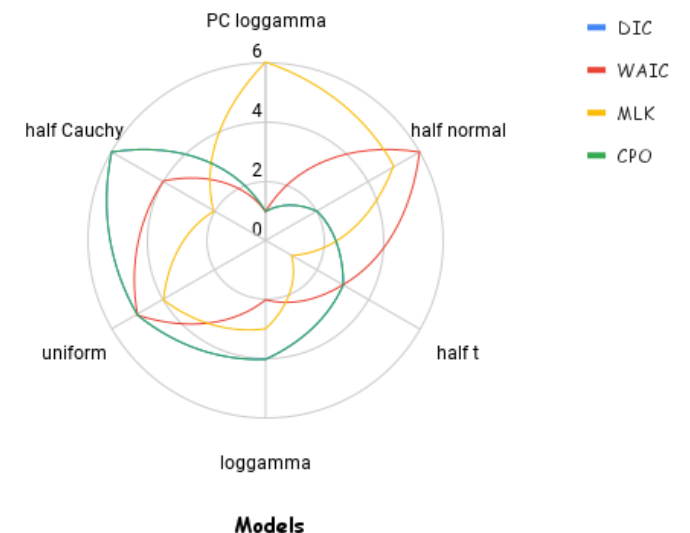
Figure 2. Posterior marginals of three input parameters—temperature, relative humidity, and wind speed (left to right) with different priors of precision. The choice of priors in Bayesian models can affect the posterior marginals of model parameters. Most of the priors produced slightly different but similar posteriors, with the exception of the half-Cauchy prior, which resulted in significantly displaced posteriors. The negative values for relative humidity indicate that higher relative humidity values are associated with a decrease in fire size.